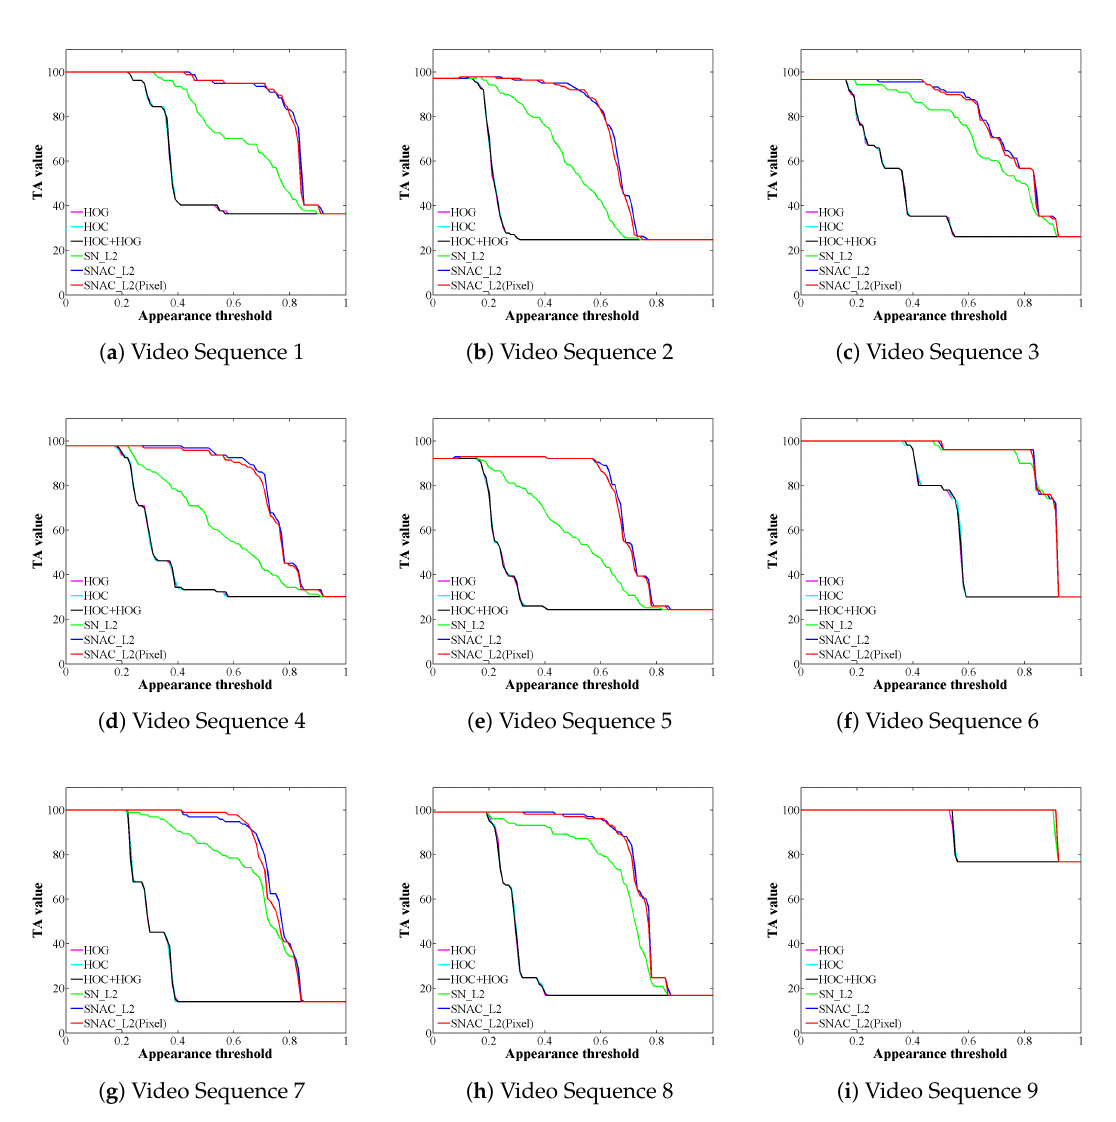
Figure 5. Illustrations of the tracklet accuracy (TA) varying with the appearance threshold. From red to pink, they represent the SNAC_L2, SN_L2, SNAC_L2(Pixel), HOC, HOG, and HOC + HOG methods. Nine video sequences were sampled from the 2D MOT 2015 dataset and annotated. The abscissa axis indicates the appearance threshold from 0–1, and ordinates axis represents the TA up to 100. Through these curves, it can be seen that learning features are better than traditional methods at distinguishing objects in multiple object tracking (MOT). The auto-encoding constraint (AC) term and histogram inputs proposed in this paper also showed reasonable